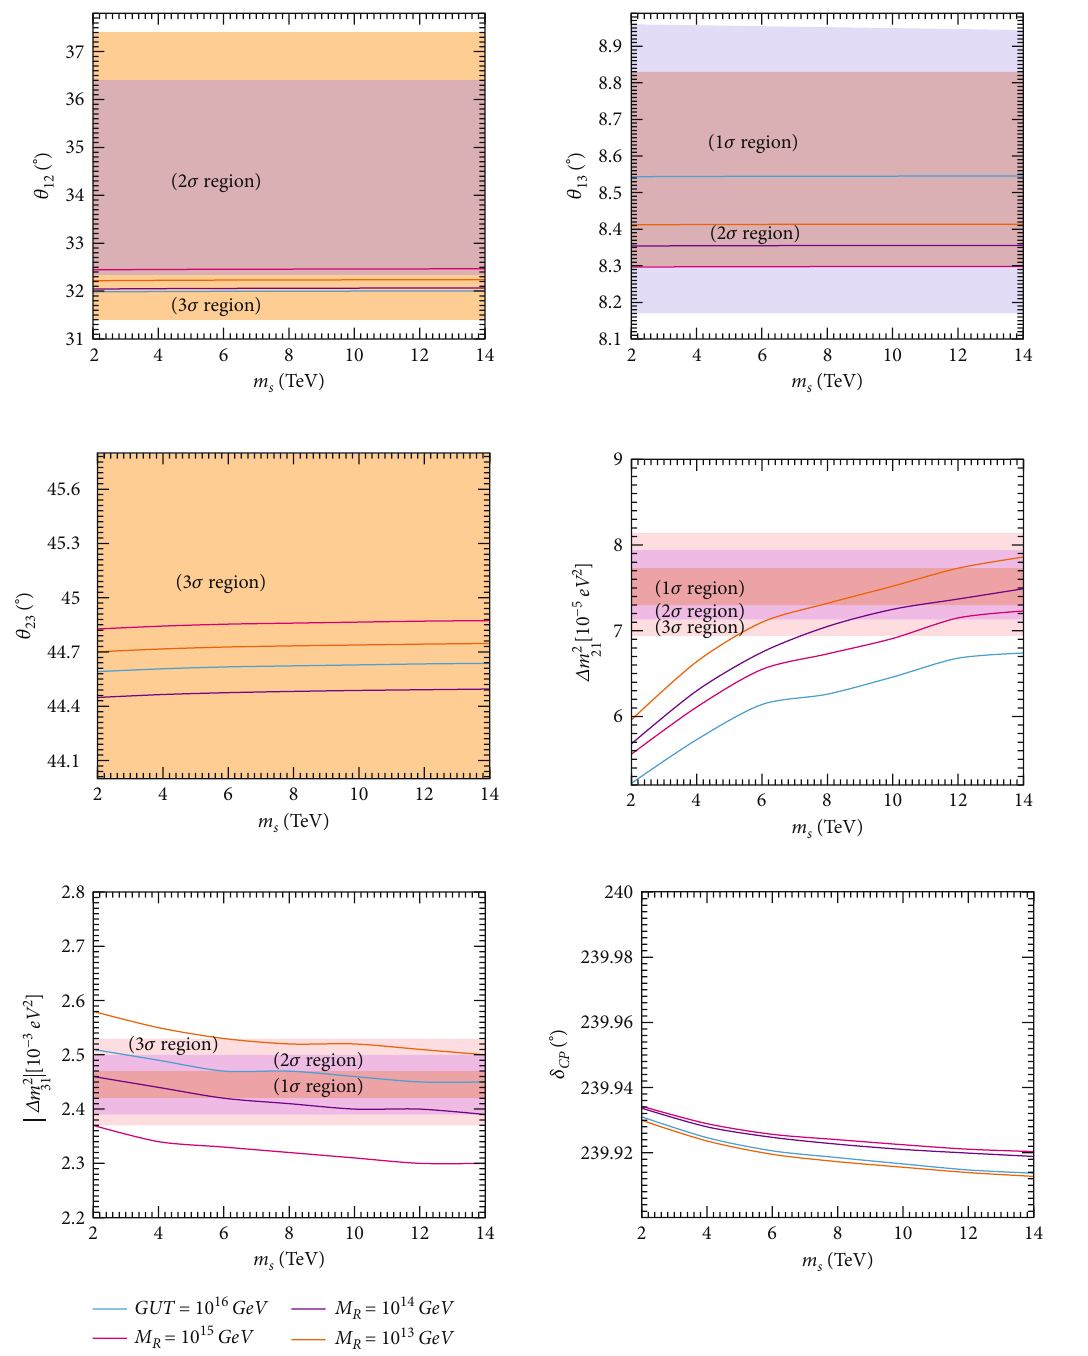
j , and δ , j Δ m 2 with variation of m ij CP ij